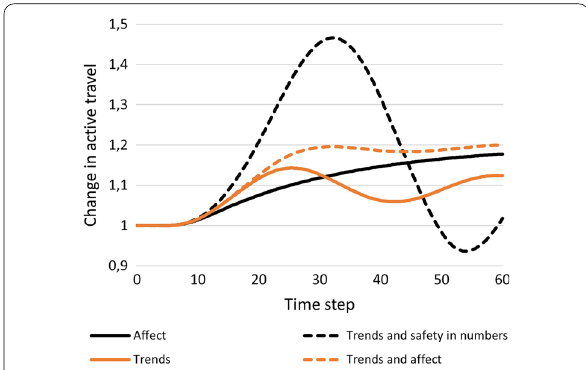
Fig. 4 Effects of an exogenous intervention under individual and combined feedback effects